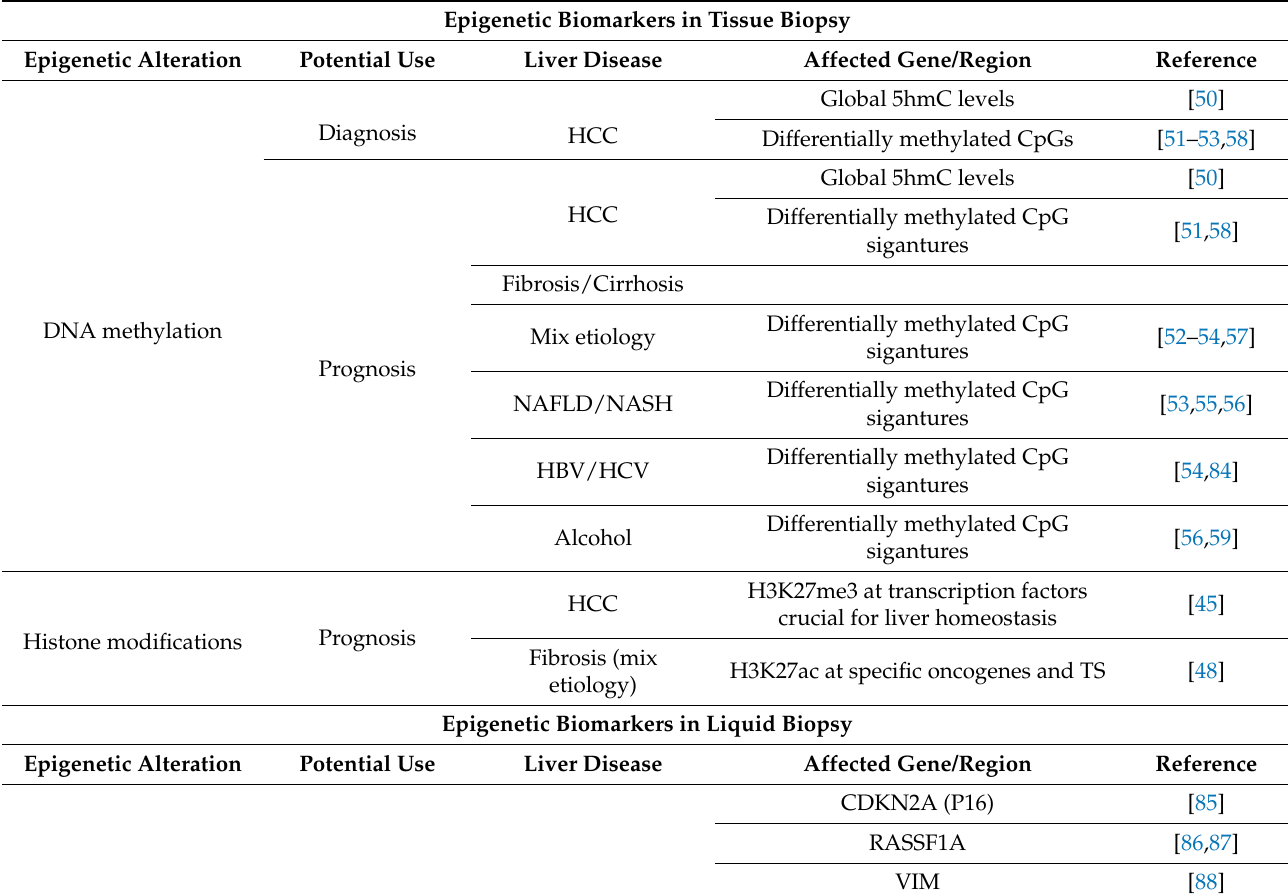
Table 1. Summary of epigenetic biomarkers found in tissue and liquid biopsies for liver disease diagnosis and